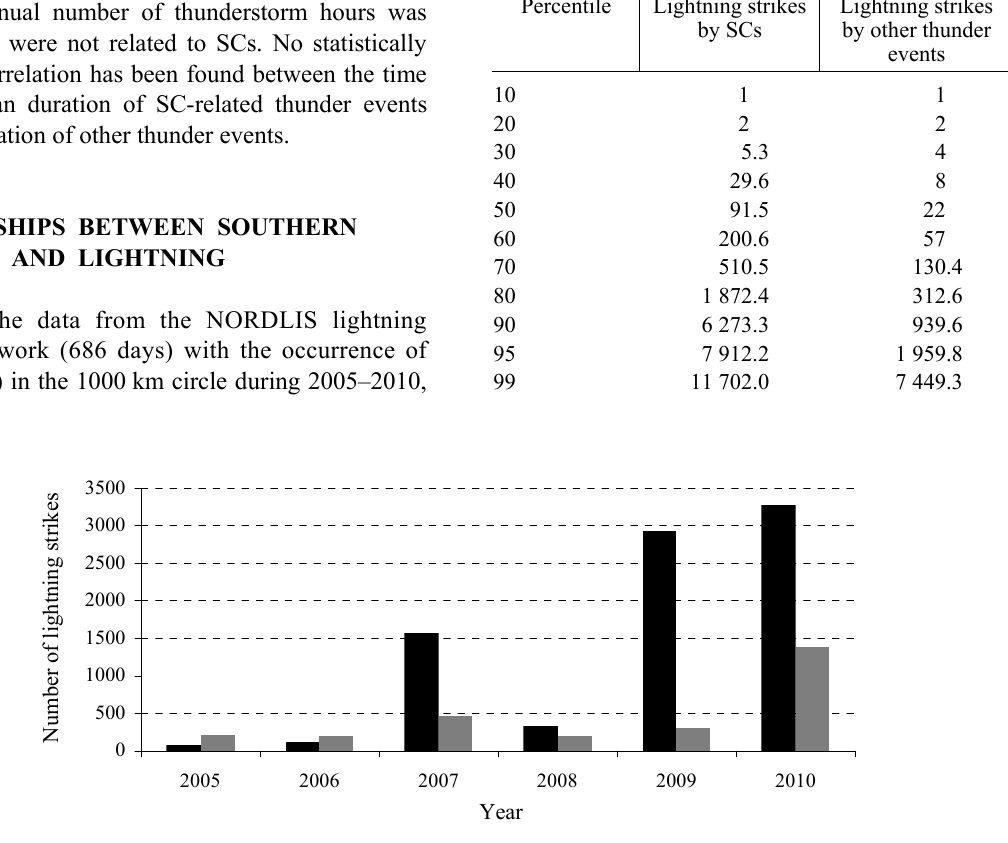
Fig. 7. Mean number of lightning strikes per day in southern cyclones (black) and in other thunder events (grey) in